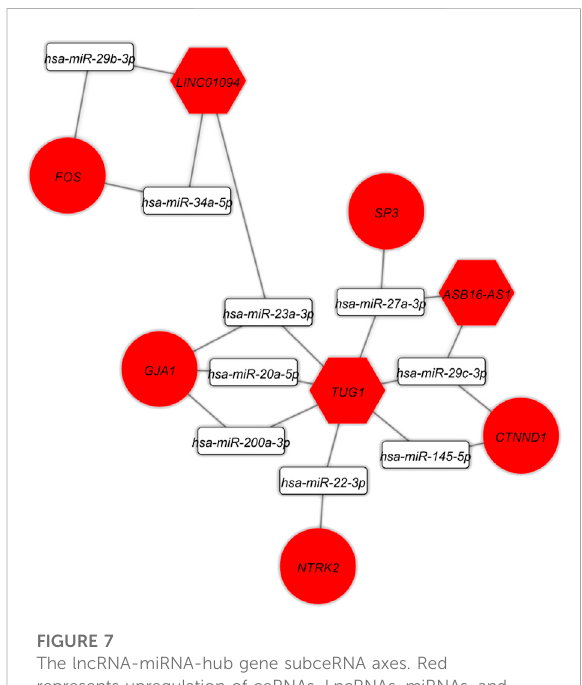
FIGURE 7 The lncRNA-miRNA-hub gene subceRNA axes. Red represents upregulation of ceRNAs. LncRNAs, miRNAs, and mRNAs are represented by hexagon, round rectangle, and ellipse,